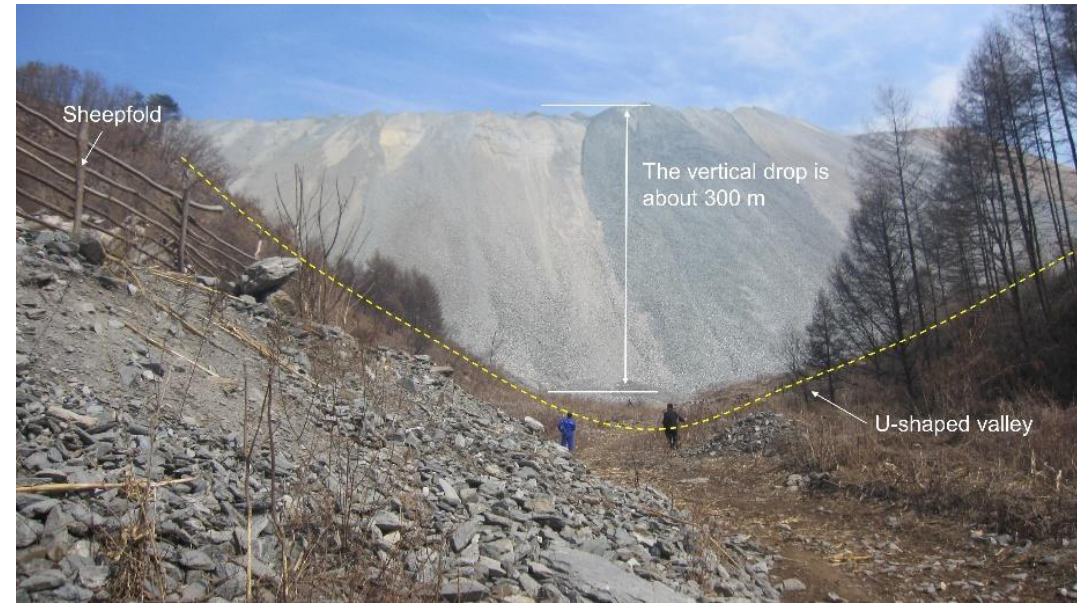
Figure 2. Image of the full high waste dump.